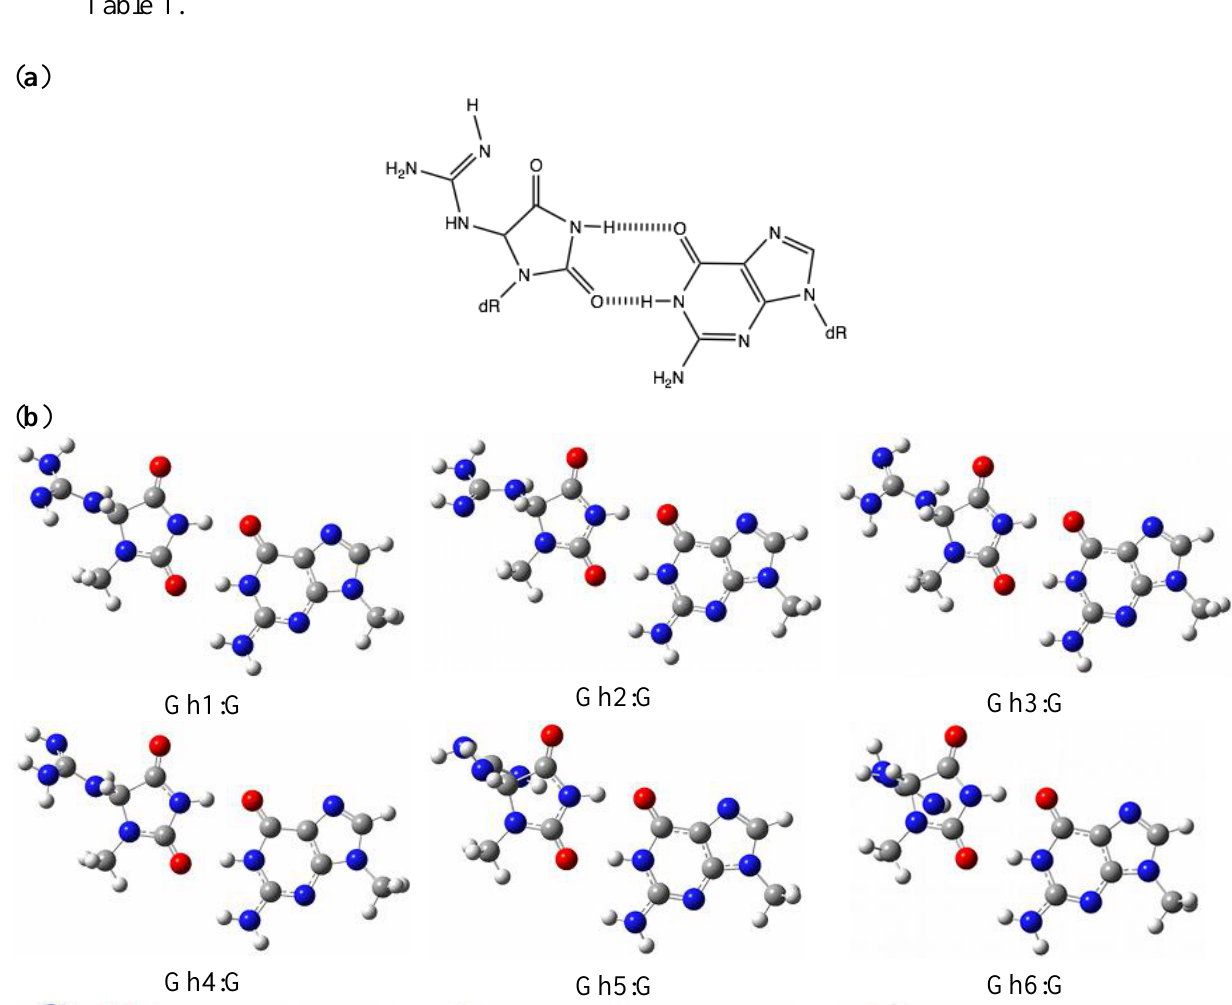
Figure 2. The Gh:G base pairs. ( a ) The proposed Gh:G base pair. ( b ) The geometries of Gh1:G-Gh16:G optimized by ab initio calculation. The stabilization energies are shown